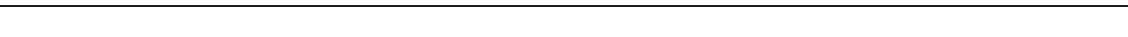
Fig. 4 TRPA1 expression level is signi fi cantly reduced upon LUAD brain metastasis. a IHC and H&E staining of lung cancer brain metastases. Upper panel: Normal brain tissue (green area), tumor tissue (black arrows), necrosis (blue arrows), and haemorrhage (red arrows). Middle panel: Higher magni fi cation of normal brain (scale bar: 100 μ m). Bottom panel: Higher magni fi cation of metastatic lung cancer (scale bar: 200 μ m) shows FGFR2-positive tumor cells with areas of negatively-stained fi brovascular connective tissue (black arrows). b Left panel: Images of IF staining at 20× magni fi cation of mouse brain slices 5 days following injection with GFP-HCC-515. CD-34 (Alexa 555) was used as a blood vessel marker. Scale bars: 20 μ m. Right panel: Percentage of cancer cells located inside vs. outside blood vessels 3 days (D3) and 5 days (D5) following injection. Error bars indicate s.d. * P ≤ 0.05. c Left panel: Two representative images from D5 (one with an additional zoom-in area). GFAP-positive reactive astrocytes (Alexa 647; pseudo colour: magenta) are shown in the vicinity of extravasating cancer cells (green) as indicated by the white arrows (arrow 1: cancer cell; arrow 2: blood vessel; and arrow 3: astrocyte). Scale bars: 20 μ m. Right panel: Bar graph representation of the number of activated astrocytes present in the vicinity of cancer cells 3 days (D3) and 5 days (D5) following injection. Cancer cell-associated astrocytes are quanti fi ed within a distance of 150- μ m from cancer cells. Error bars indicate s.d. * P ≤ 0.05. d Left panel: TRPA1 expression (Alexa 647; pseudo colour: cyan) in cancer cells 3 days (D3) and 5 days (D5) following injection. Scale bars: 20 μ m. Right panel: Extravasated cancer cells were counted in 20 randomly chosen fi elds per brain followed by calculation of TRPA1-positive cells. Error bars indicate